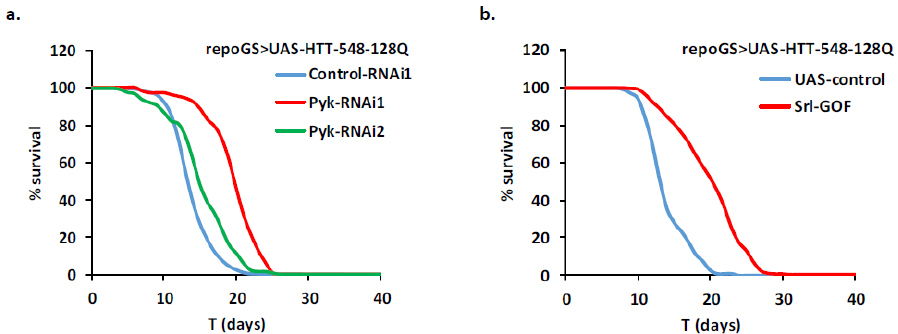
Figure 3. Identification of modifiers of mHTT-induced glial pathology involved in energy pro- duction. A repoGS > UAS-HTT-548-128Q line was crossed with transgenic lines modulating Pyk (Pyk-RNAi1 and Pyk-RNAi2) and srl (srl-GOF) genes (see Table S4 for detailed genotypes) and the progeny were scored for their lifespan after induction with RU100. ( a ) Adult glia depletion of Pyk with 2 independent RNAi lines results in increased lifespan of mHTT expressing flies (MLS = 18.7, 14.4; pLogRank < 10 −10 , 10 −5 ; n = 106, 131, respectively). Control flies: MLS = 13.2, N = 147. ( b ) Overexpression of srl is also strongly protective, as shown by two independent experiments (MLS= 19.9, 18.2; pLogRank < 10 −10 , 10 −10 ; n = 144, 136, respectively). Control flies: MLS = 13.3, n = 106.